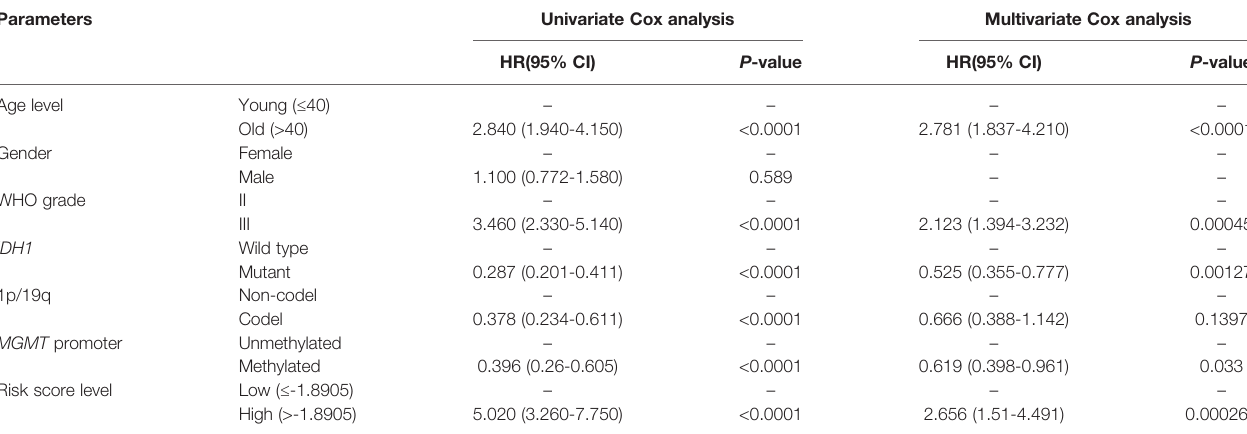
TABLE 2 | Univariate and multivariate Cox analysis of OS in TCGA-LGG dataset.